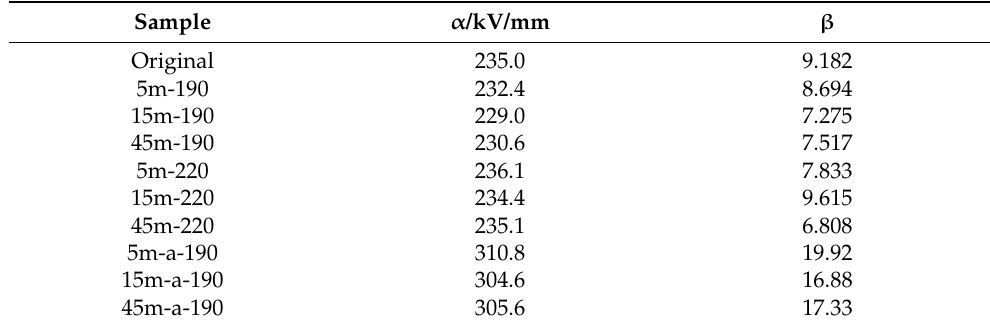
Table 2. Scale parameter ( α ) and shape parameter ( β ) of